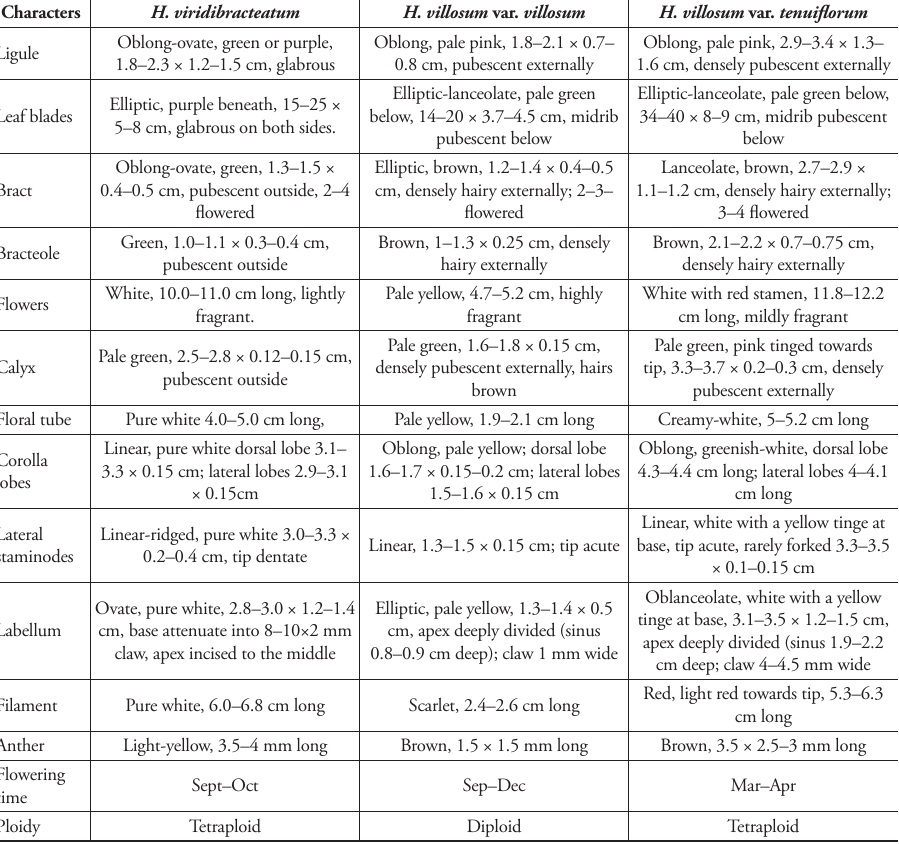
Table 1. A morphological comparison of Hedychium viridibracteatum with related